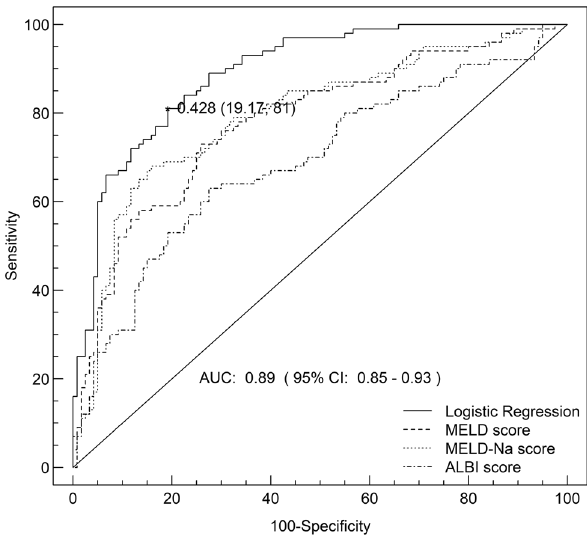
Figure 2: ROC curve corresponding to LR ( p ) , MELD, MELD - Na, and ALBI. LR ( p ) was the newly established prediction model in this